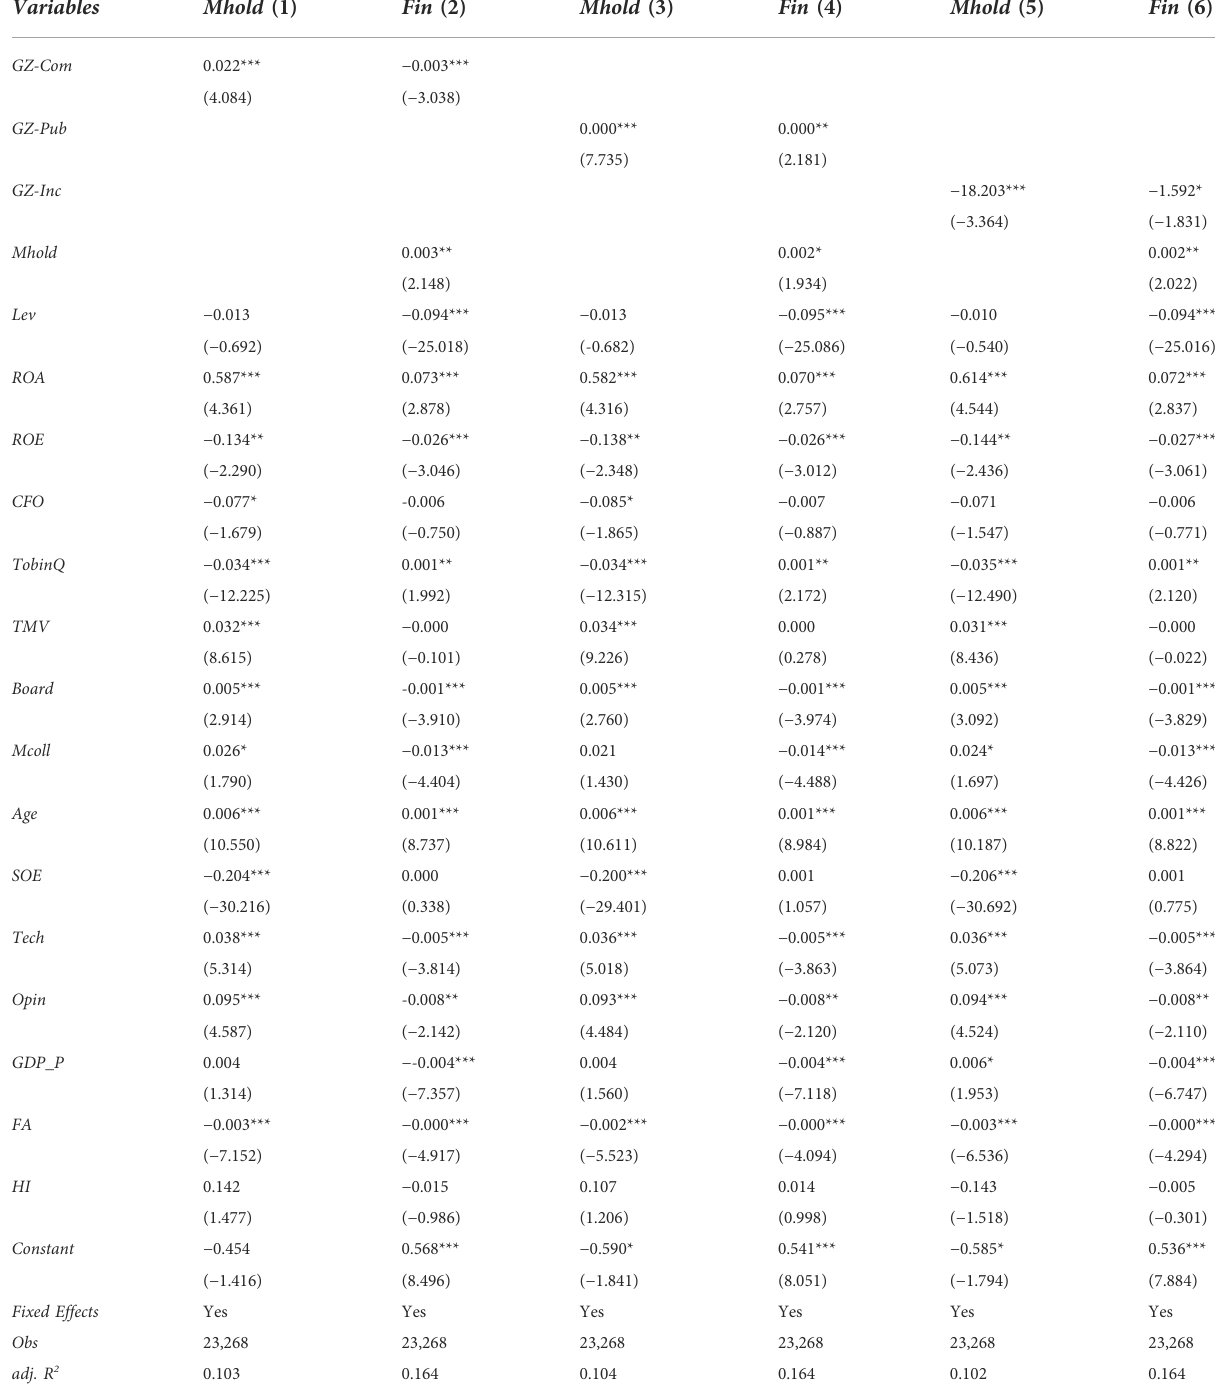
TABLE 7 Test of managerial incentive